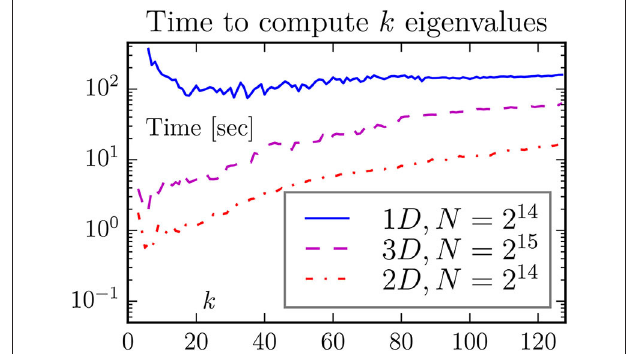
FIGURE 6 | The discretization error of energy eigenvalues when using the standard 5-stensil approximation for the two-dimensional Laplace operator. 6 Exactly, the states E 78 and E 90 are the two edges of a 13-member multiplet = with energy 26, and the state E 12 is the middle member of a 5-member multiplet with energy 10. With the chosen parameters all states considered a well confined inside the geometric region; hence we do not observe any boundary correction effects.